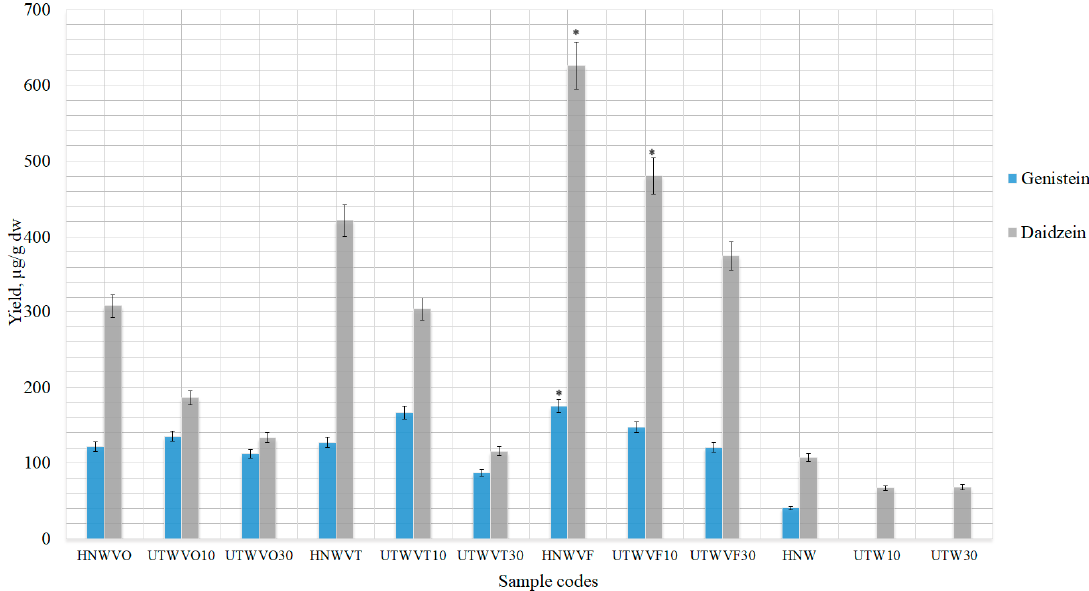
Figure 9. Quantitative yield of isoflavone aglycones using different amounts (1, 2.5 and 5%) of vinylpyrrolidone-vinyl acetate copolymer for extractions. Control samples without excipients (HNW; UTW10; UTW30), 1% of excipient (HNWVO; UTWVO10; UTWVO30), 2.5% (HNWVT; UTWVT10; UTWVT30) and 5% (HNWVF; UTWVF10; UTWVF30). * p < 0.05